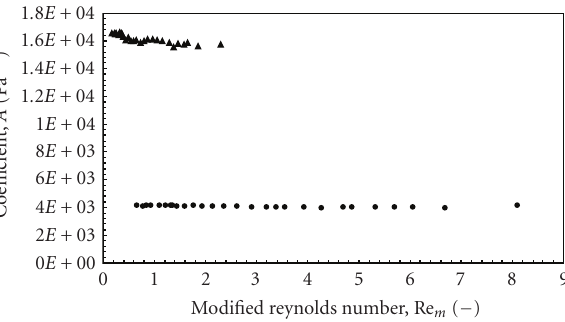
Figure 6: Variation of coe ffi cients A for both sinkers modified reynolds number. (cid:2) sinker 1; •